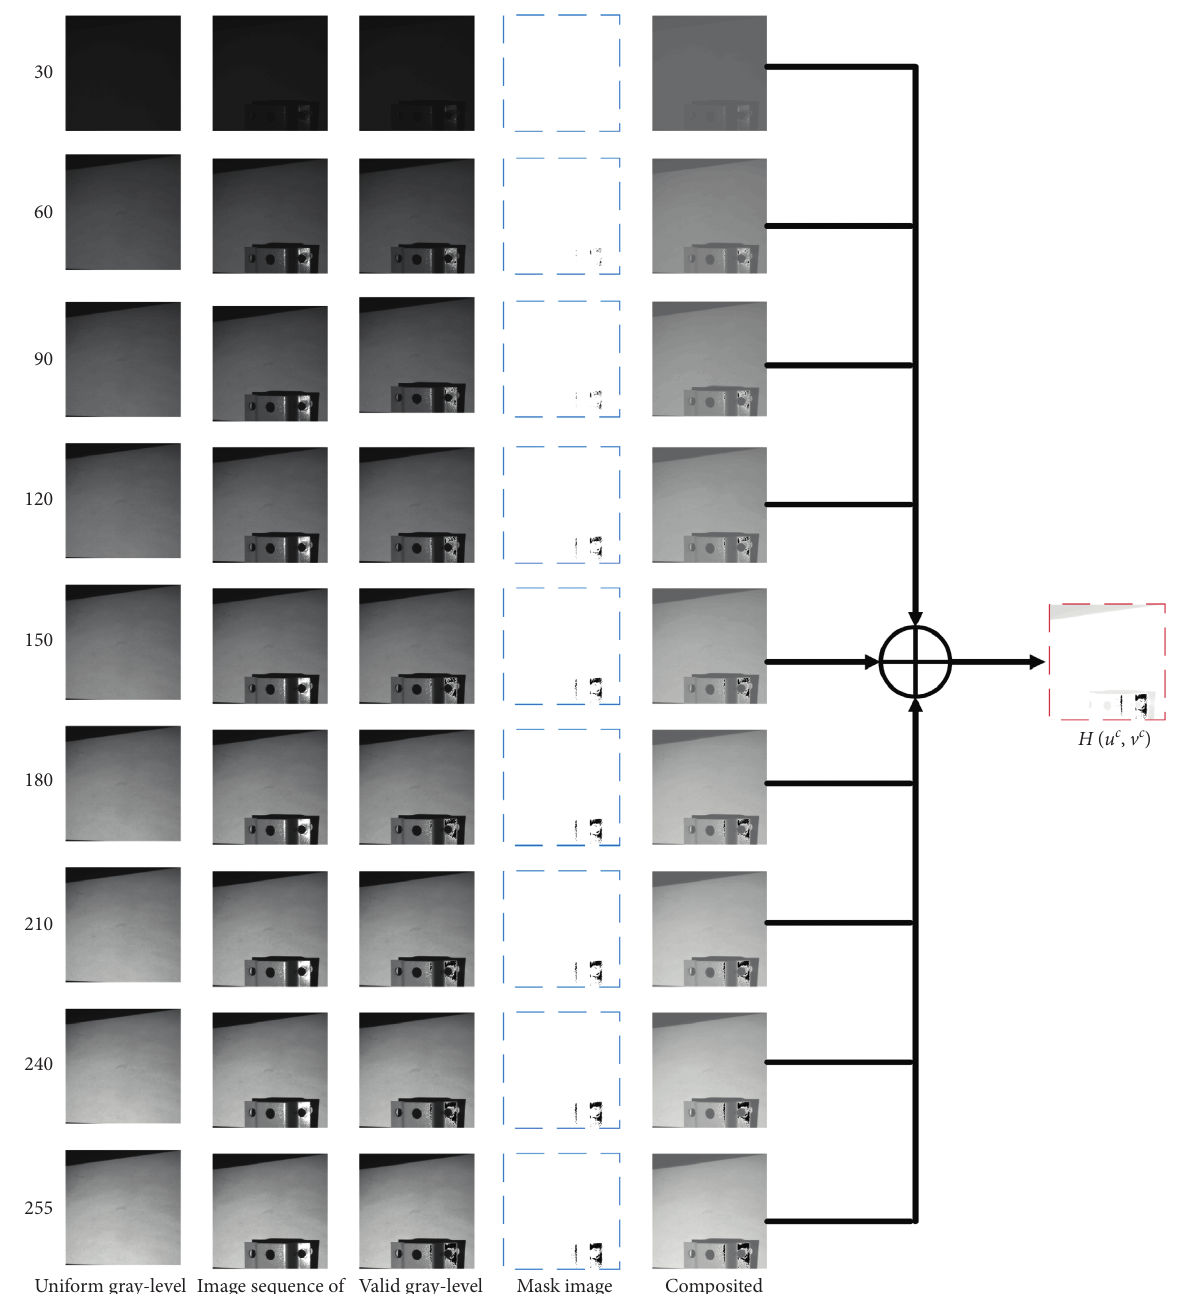
Figure 7: Schematic diagram of the synthetic image